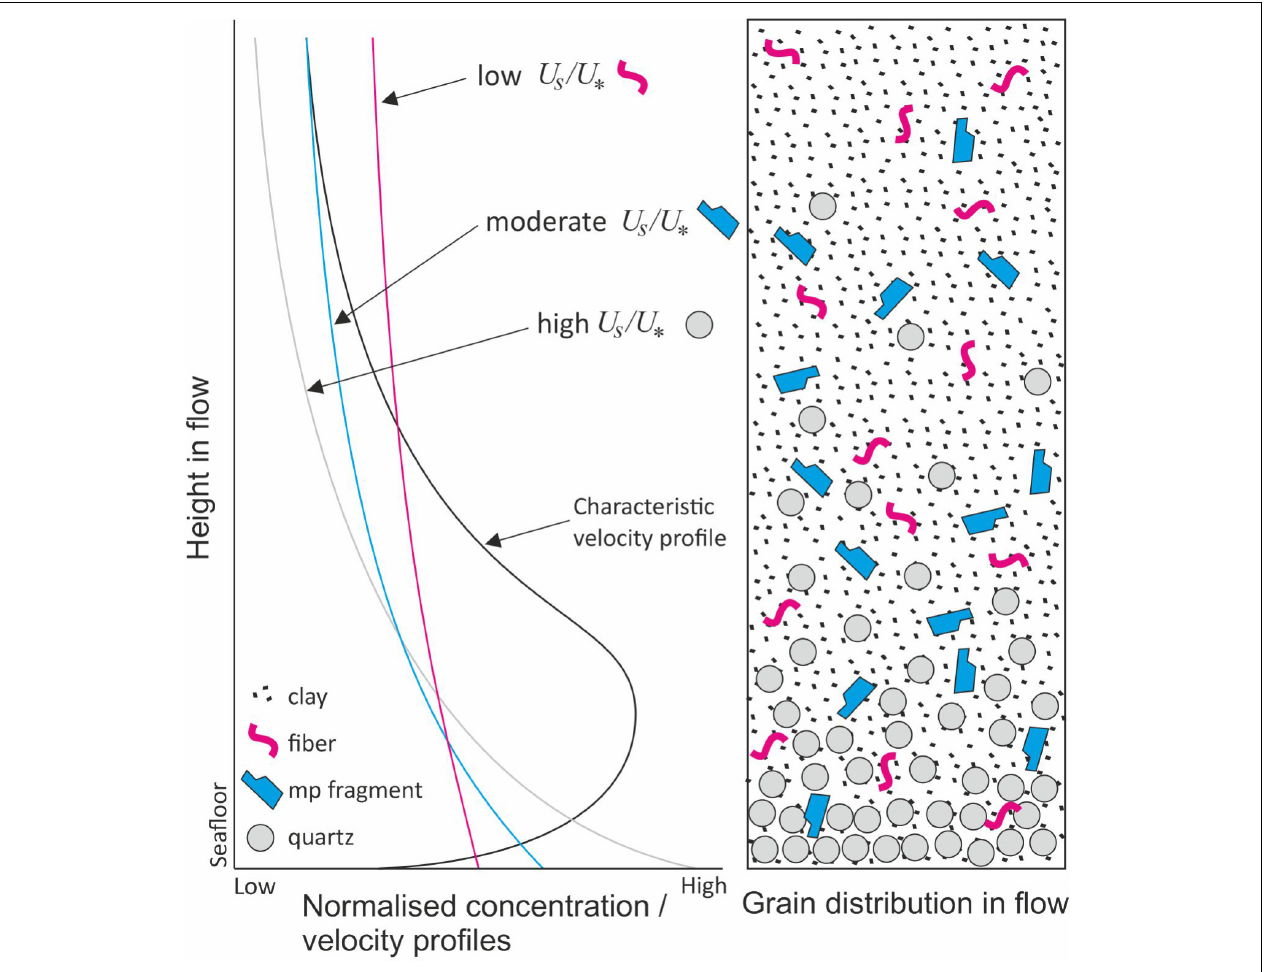
FIGURE 9 | Sediment distribution in a turbidity current. Particles with a relatively low settling velocity ( U s ), in comparison to the shear velocity ( U ∗ ), e.g., microplastics, will tend to be more homogenously distributed throughout the flow than those with a high settling velocity, e.g., quartz and feldspar. U s , settling velocity; U ∗ , shear velocity. Where microplastics end up in the flow deposits depends on the rate of flow deceleration, e.g., they might be distributed throughout high-density turbidites, but concentrated at bed tops in low-density turbidites. Modified from Hansen et al.